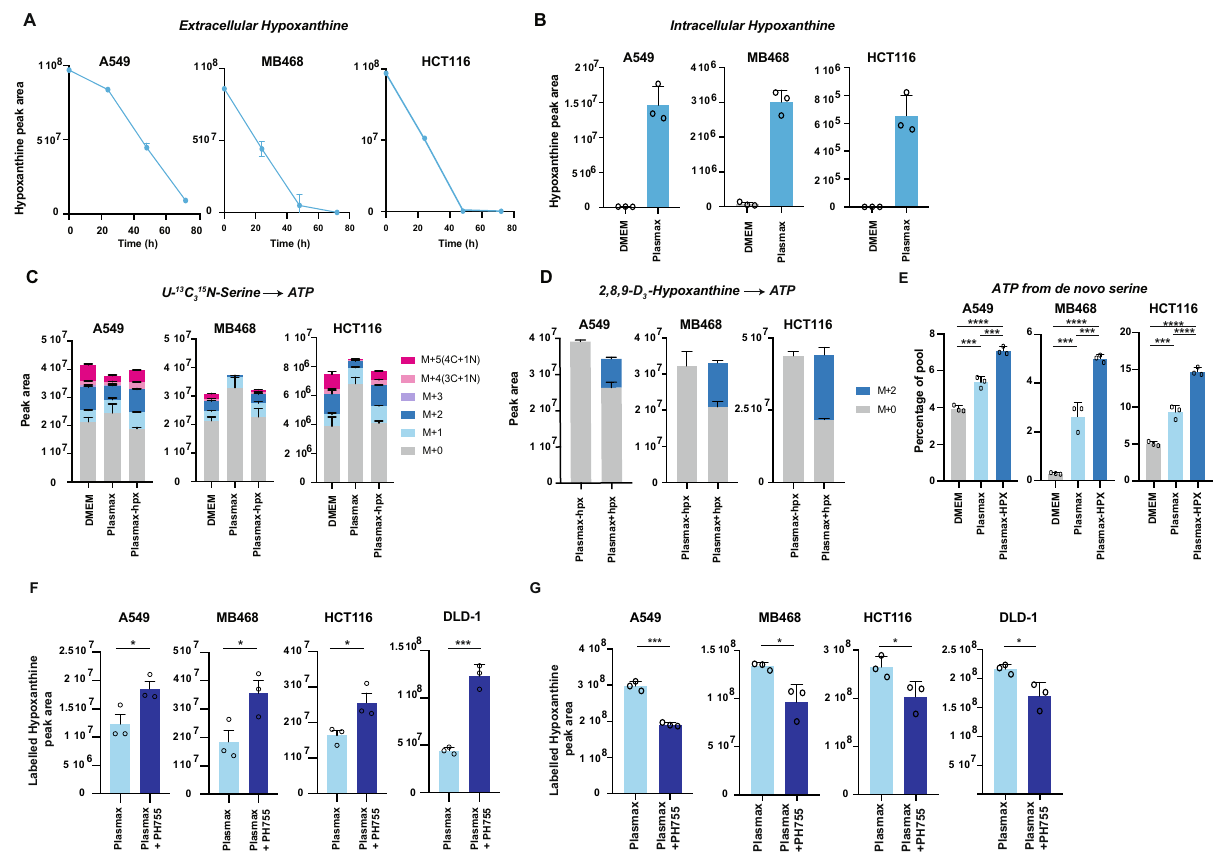
Fig. 3 Hypoxanthine salvage is a major contributor of purines in Plasmax. A Extracellular levels of hypoxanthine measured by LC – MS in supernatants of cells grown in Plasmax (blue) for up to 72h. Data are represented as mean± SD of triplicate wells. B Intracellular levels of hypoxanthine measured by LC – MS in cells grown in DMEM (grey) or Plasmax (Blue). Data are represented as mean± SD of triplicate wells. C Intracellular levels of ATP measured by LC – MS after incubation for 4h with 400, 140 or 140 µ M of 13 C 3 - 15 N-Serine in DMEM, Plasmax or Plasmax-hpx, respectively. Data are represented as mean± SD of triplicate wells. D Intracellular levels of ATP measured by LC – MS after incubation for 4 h with 5 µ M of 2,8,9-D 3 -hypoxanthine or not in Plasmax. Data are represented as mean ±SD of triplicate wells. E Sum of ATP M + 6, ATP M + 7, ATP M + 8, ATP M + 9 pools measured by LC – MS after incubation of cells for 4 h with 22.5mM or 5.5 mM U- 13 C-glucose in DMEM (grey), Plasmax (light blue) or,Plasmax-hpx (dark blue), respectively (same experiment as Fig. 2F but with an extra condition). Data are represented as mean± SD of triplicate wells (one-way Anova, *** p <0.001, **** p < 0.0001). F Cells were grown 24h in Plasmax containing 2,8,9-D 3 -hypoxanthine with (light blue) or without (dark blue) 10 µ M PH755 before intracellular labelled 2,8,9-D 3 -hypoxanthine was measured by LC – MS. Data are represented as mean± SD of triplicate wells (unpaired Student ’ s t test, * p < 0.05, *** p < 0.001). G Cells were grown 24h in Plasmax containing 2,8,9-D 3 -hypoxanthine with (light blue) or without (dark blue) 10 µ M PH755 before labelled 2,8,9-D 3 -hypoxanthine was measured in supernatants by LC – MS. Data are represented as mean± SD of triplicate wells (unpaired Student ’ s t test, * p < 0.05, *** p < 0.001). All graphs are representative of 3 independent experiments. Source data are provided as a Source Data fi